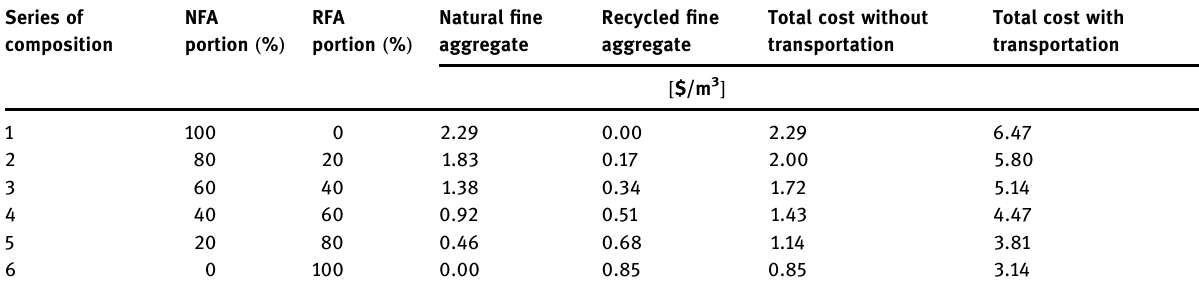
Table 3: The estimated costs of each fi ne aggregate mix used in the epoxy resin coating with RFA ( in $/m 3 ) Series